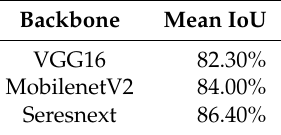
Table 5. Results of hand component